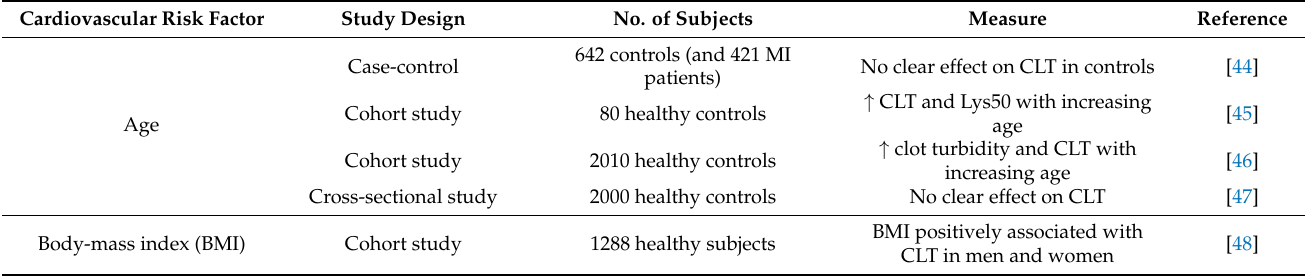
Table 1. Cardiovascular risk factors in association with fibrin clot properties.